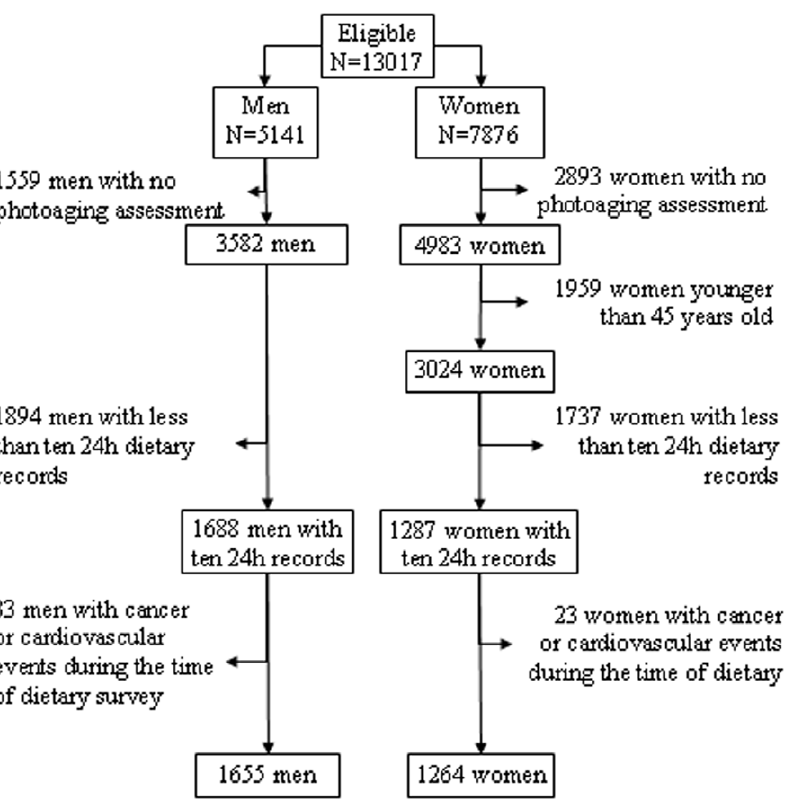
Figure 1. Flow chart of participants from the SU.VI.MAX study cohort retained in the analysis.